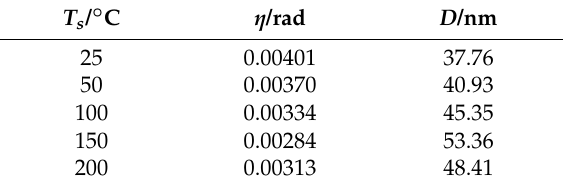
Table 3. Microstructure parameters of the ZnO waveguide layers at the different sputtering temperatures.